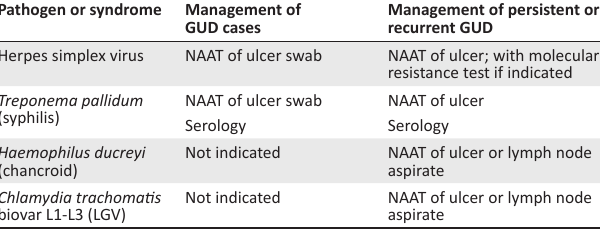
TABLE 5b: Recommended diagnostic tests for management of sexually transmitted infection-associated symptoms – Genitalulcer ulcer